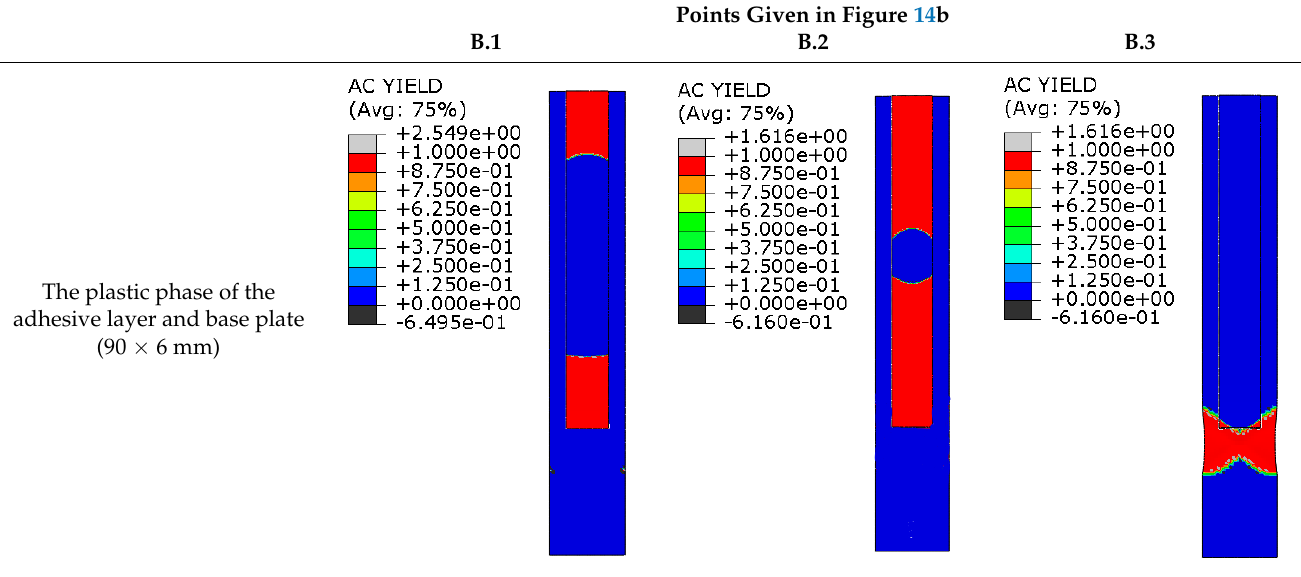
( b ) Figure 19. Stresses in the adhesive layer taken from numerical model: ( a ) shear stresses ( b ) tensile (peeling) stresses. An analogous analysis was performed for an effective joint length of 400 mm. In this case, maps of the plastic work of the adhesive and of the plasticization of the base plate (90 × 6mm) were most important. The results are shown in Table 6. At a force of about 270 kN (point B.1), which is well before the visible plasticization of the entire model, local plasticization of the adhesive layer occurred at both ends of the contact surface between the overlap and the base flat bar. A further increase in force, up to point B.2 (ca. 333 kN), led to the development of a zone of plasticization of the adhesive, which at that time cov-